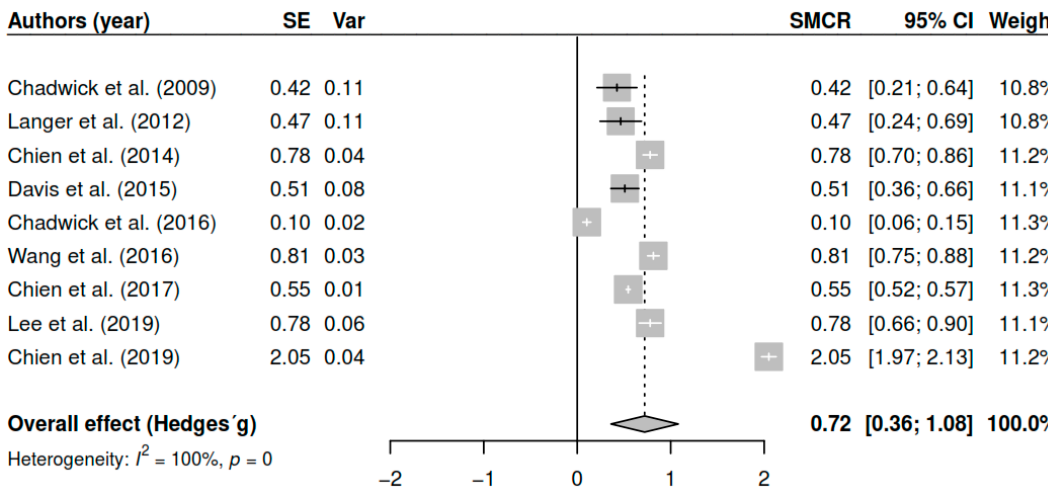
Figure 2. Forest plot for the model of random-e ff ects and the values of Hedges’ g statistics in the overall symptomatology variable